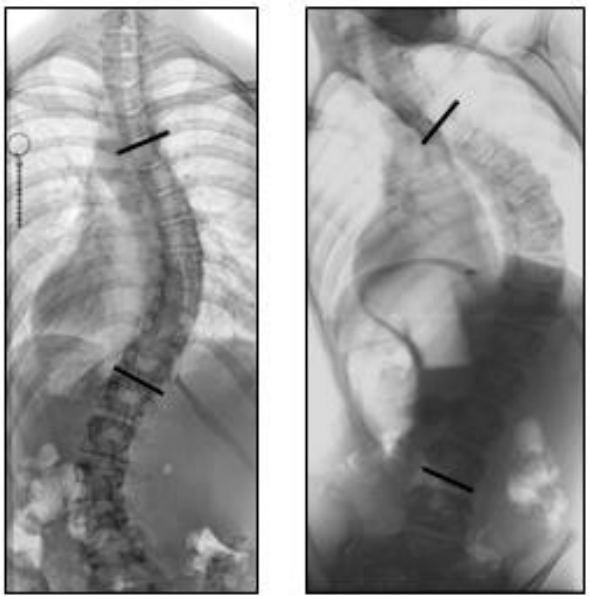
Figure 1. Two examples of different scoliosis curve types. On the left is an idiopathic-like curve, which is S-shaped with the apex of the major curve located at vertebral level T9 and a curve length of 8 vertebrae. On the right is a non-idiopathic neuromuscular-like curve, which is C-shaped with a curve length of 12 vertebrae, and a lower-end vertebra located at level L4.